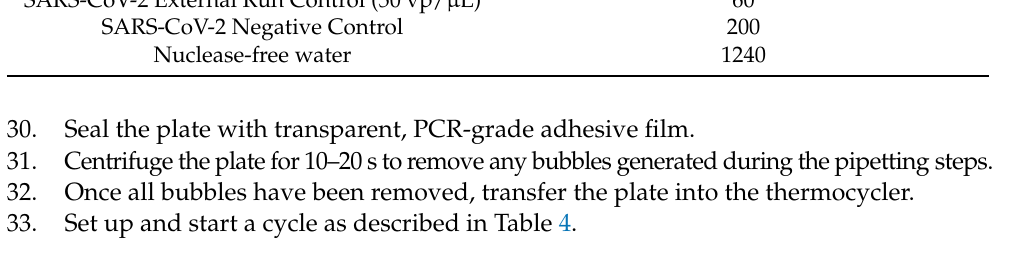
Table 4. Thermocycler settings for each step of the PCR cycle.